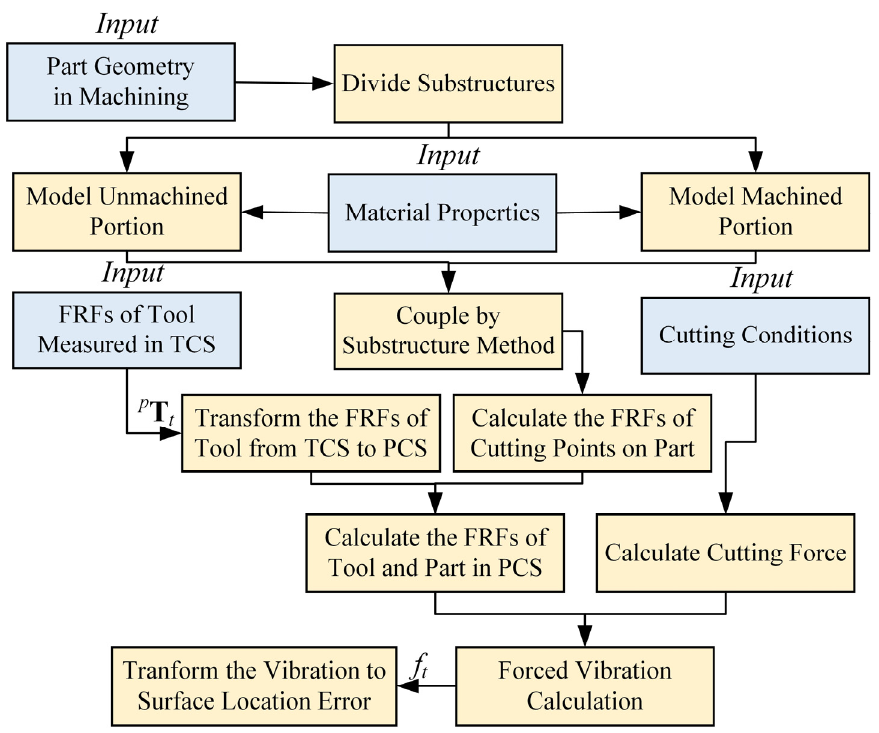
Figure 5. Flowchart for the prediction of SLE.